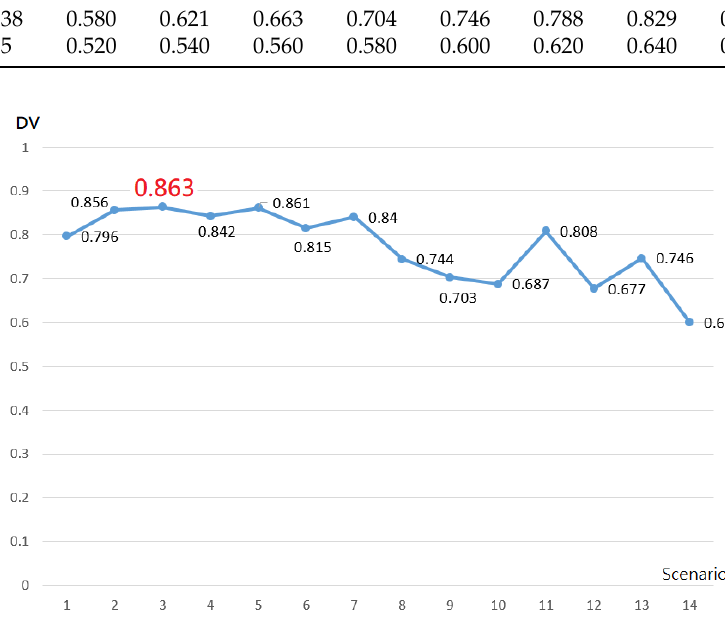
Figure 1. Decision value for each scenario when DW = 0.5.